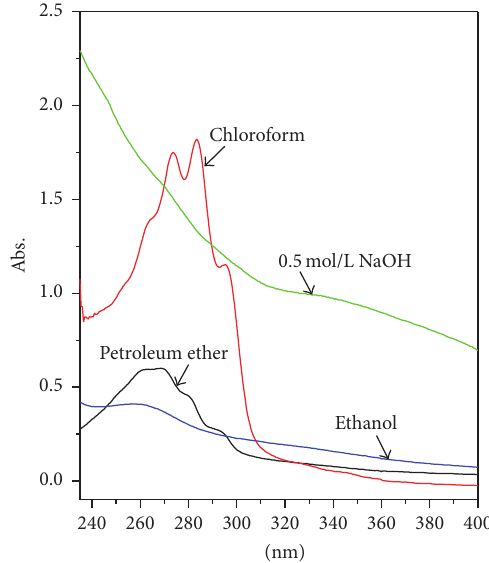
Figure 1: UV spectra of different extraction solvents.